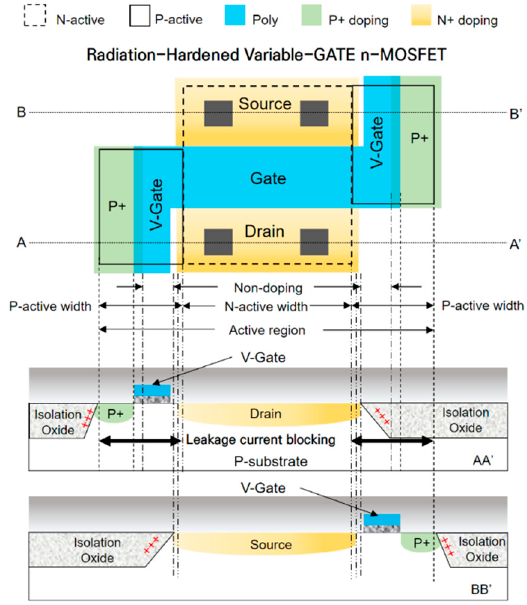
Figure 9. Cross-sectional view of the RH V-gate n-MOSFET.